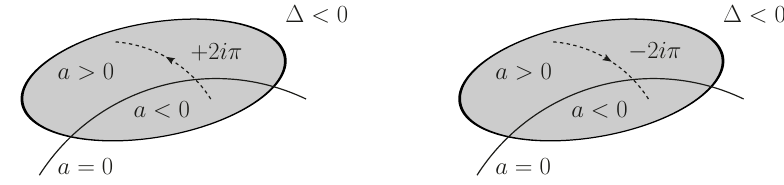
Figure 2. Definition of the single-valued logarithms of the parity odd letters in the physical region ∆ < 0 (shaded). The discontinuity at a k = 0 is added or subtracted depending on the direction of the branch-cut